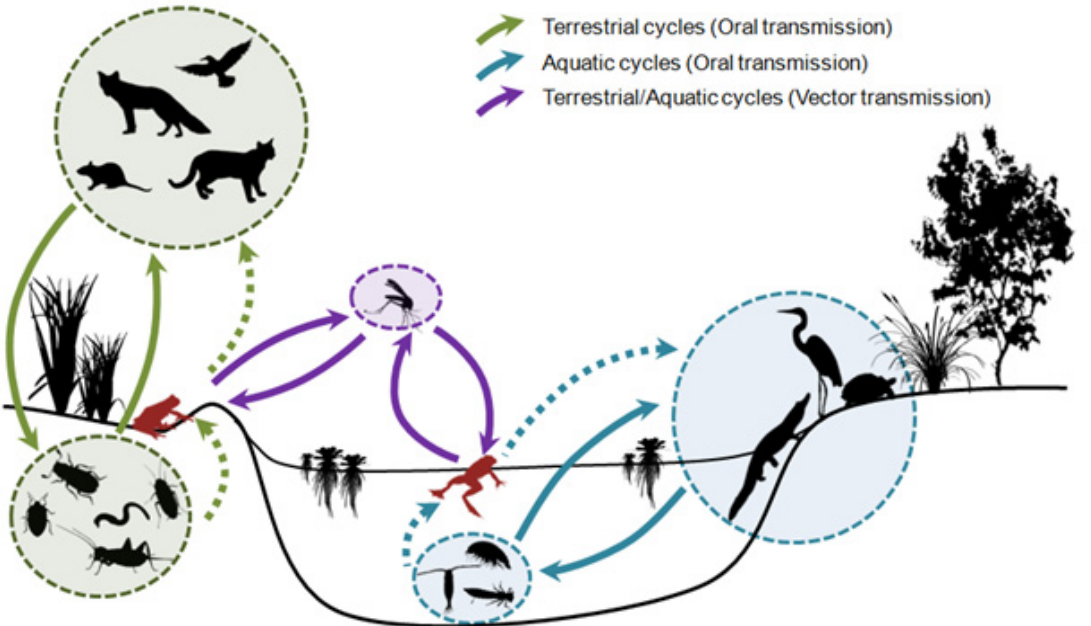
Figure 7. Schematic compilation of heteroxenous life cycles of parasitic nematodes found in amphibians of the Dry and Humid Chaco, in aquatic and terrestrial environments. Solid lines represent life cycles with “typical hosts”; the dotted lines represent the role of amphibians as paratenic hosts in these